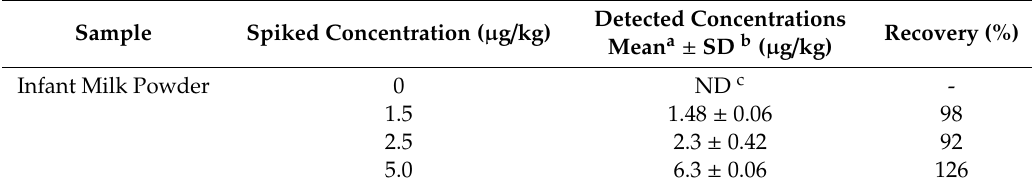
Table 2. Determination of AFM 1 spiked into infant milk powder samples.